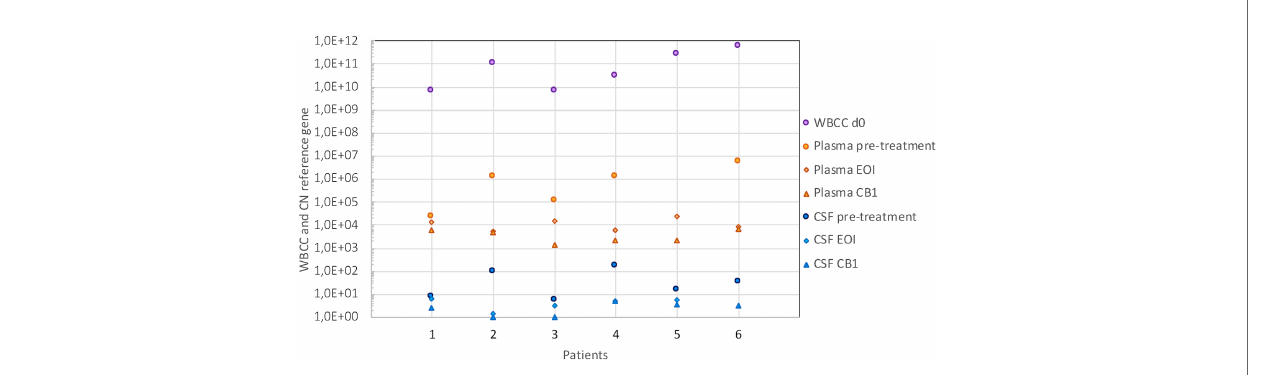
FIGURE 4 | WBCC and cfDNA levels in plasma and CSF. cfDNA level expressed as CN of reference gene/ml in plasma (orange symbols) and CSF (blue symbols) in pretreatment samples (circles), at the end of induction (EoI) (diamonds) and the end of fi rst block of consolidation therapy (CB1) (triangles). Purple circles indicate the WBCC at presentation (cells/L). The reference range for WBCC is 5.0 – 15.0 × 10 9 /L. WBCC, white blood cell count; cfDNA, cell-free DNA; CSF, cerebrospinal fl uid; CN, copy